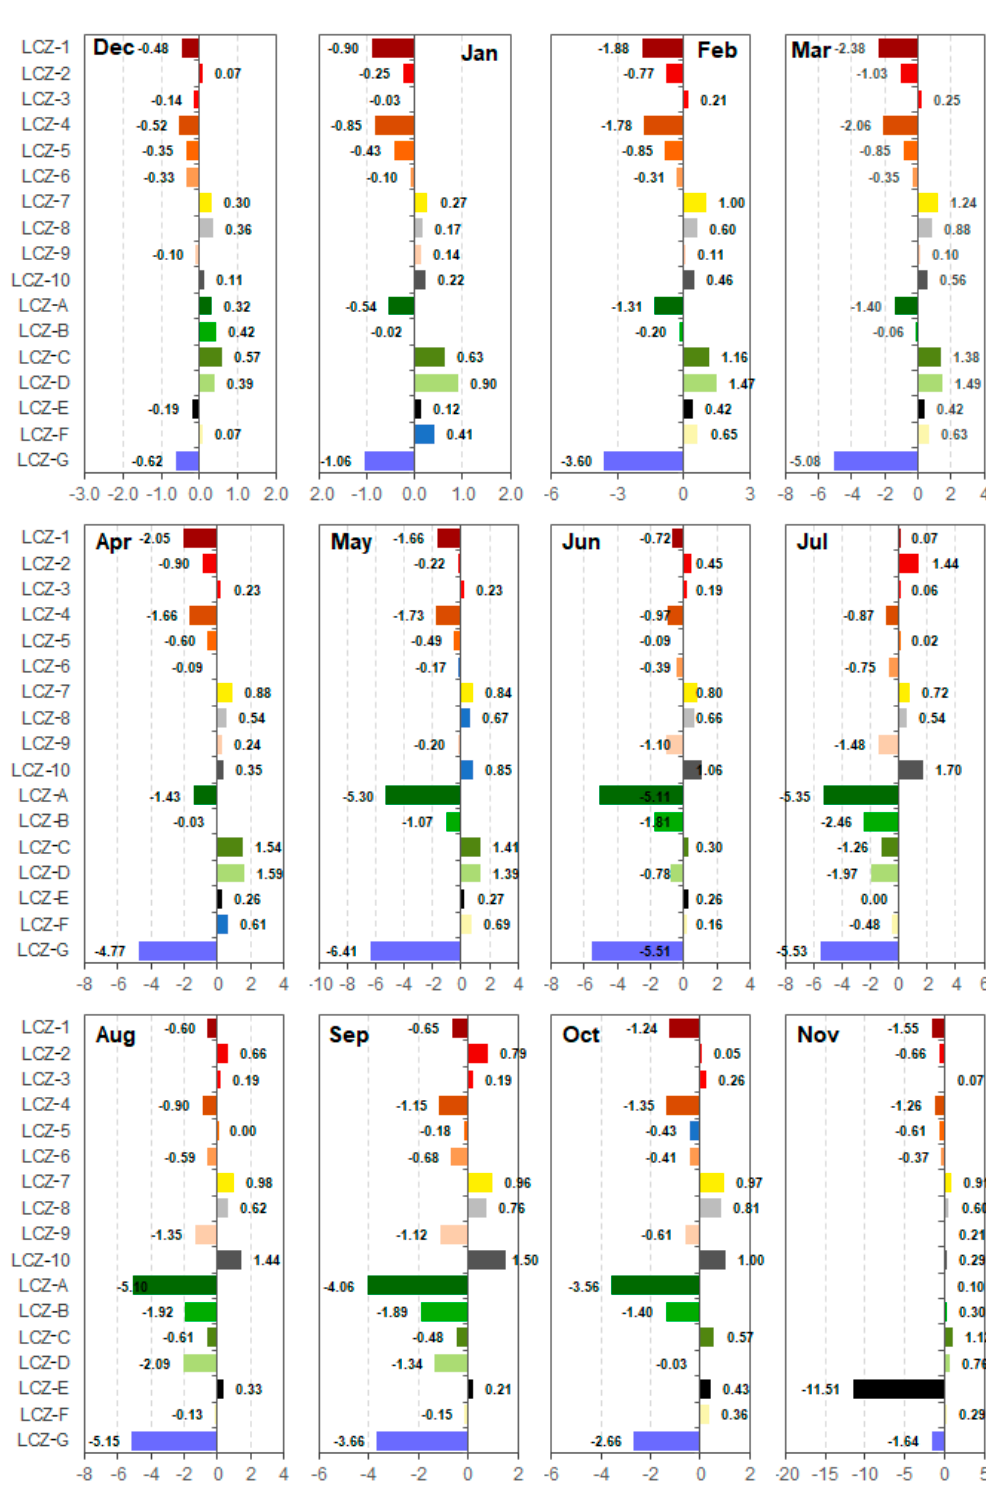
Figure A1. Deviation of the LST of Different Types of LCZs from the Average LST within an Urban Context (°C).